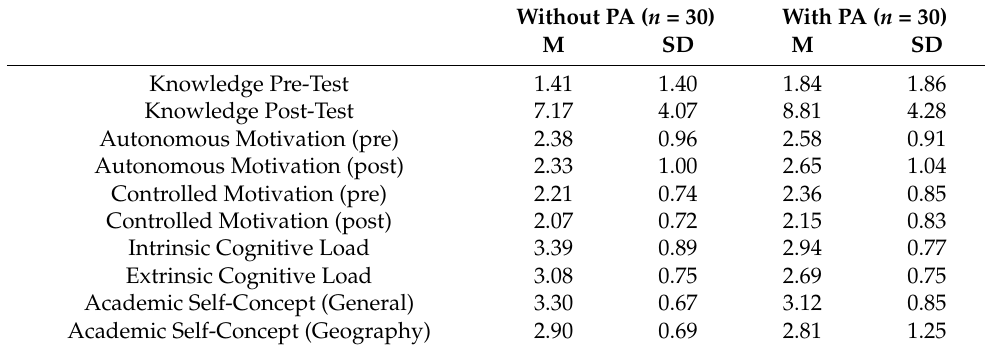
Table 1. Mean values and standard deviations of dependent and control